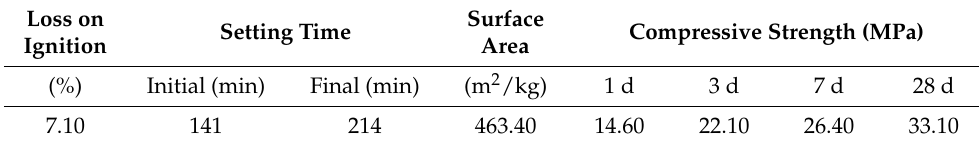
Table 2. Physical properties of cement Portland CPII-Z-32 [46].